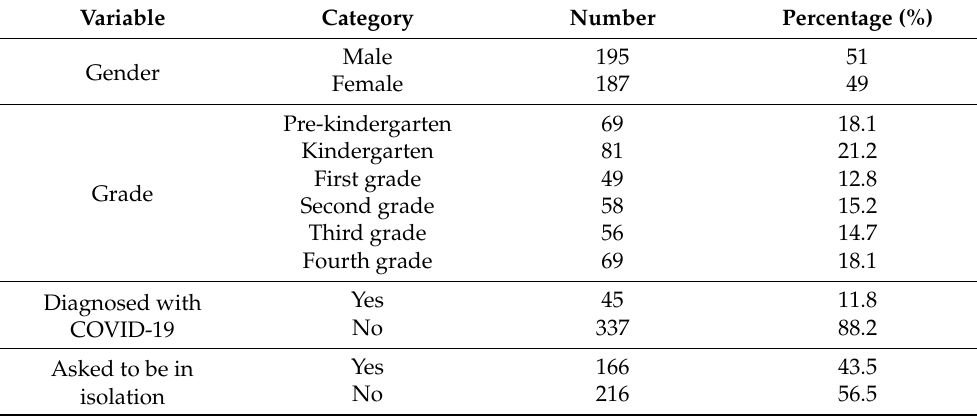
Table 2. Socio-demographic characteristics of the